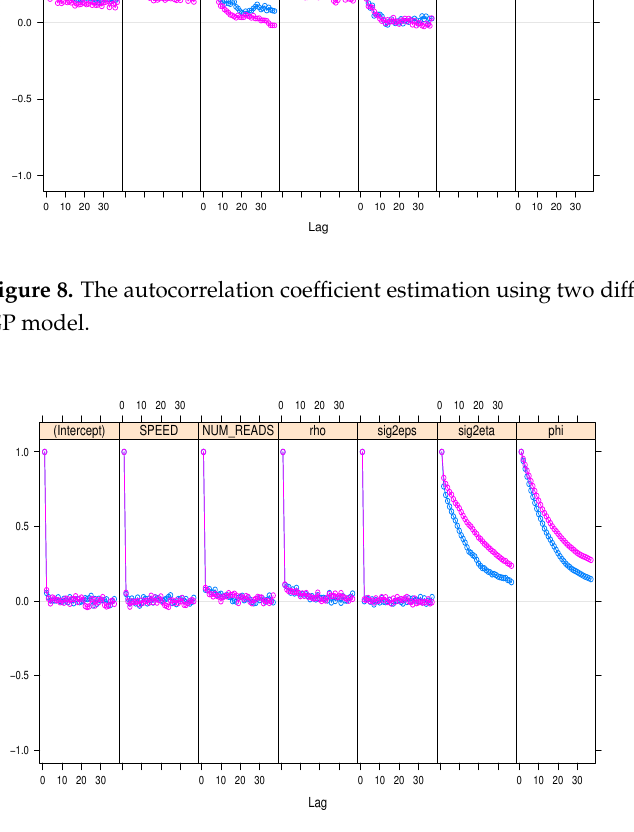
Figure 9. The autocorrelation coefficient estimation using two different lists of MCMC chains in the AR model.